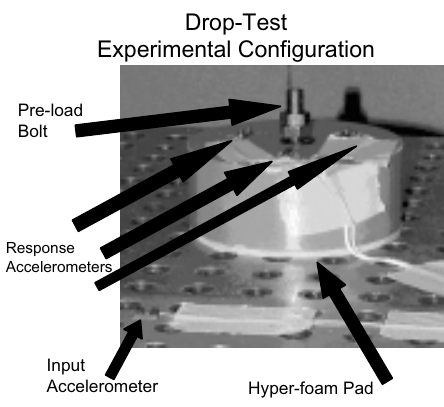
Fig. 3. LANL impact test